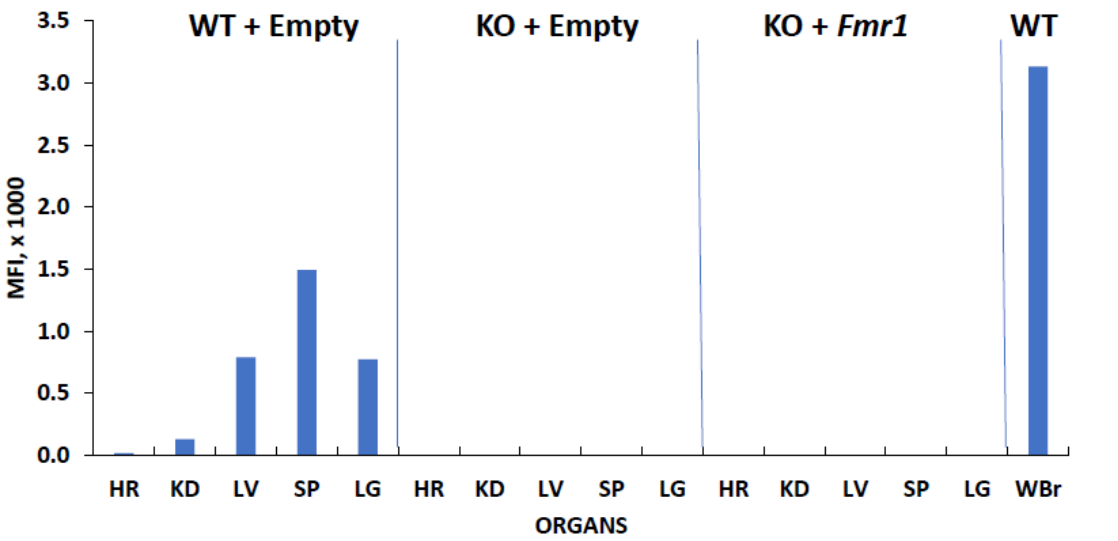
Figure 3. FMRP expression in various tissues. The mouse tissue lysates (10 µ g) from the wildtype (WT + Empty) and knockout animals with (KO + Fmr1) and without (KO + Empty) Fmr1 treatment were subjected to relative qFMRPm assessment. The FMRP levels in the whole brain in the WT mice were used as the positive control for expression (WBr). Abbreviations of lysates: heart (HR), kidney (KD), spleen (SP), liver (LV), lung (LG).